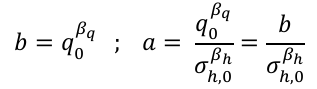
If compared to equation (14), the governing equation of the model rearranged in equation (15) allows to provide a mechanical interpretation to the material parameters. More specifically (i) the parameter q maximum value of distortion energy density at an hydrostatic angle equal to 90°, i.e. stress state condition with hydrostatic component of the stress tensor equal to zero and (ii) the parameter  of hydrostatic energy density at hydrostatic angle equal to 0, i.e. stress state condition with deviatoric component of the stress tensor equal to